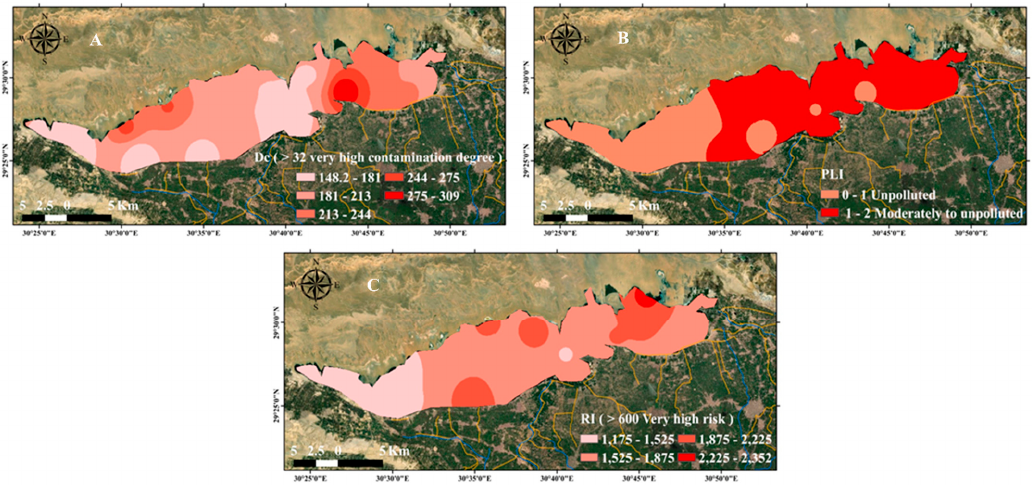
Figure 3. Spatial distribution maps of sediment quality indices: ( A ) Degree of contamination (Dc); ( B ) Pollution load index (PLI); and ( C ) potential risk index (RI) in the year 2019.